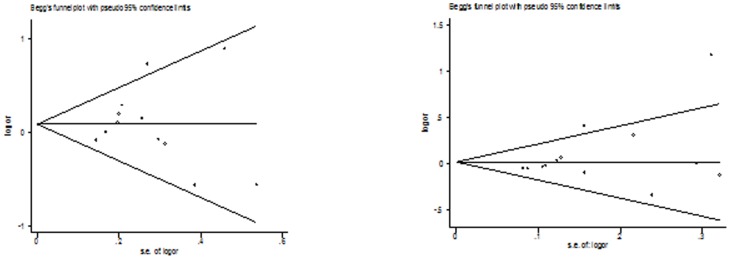
Begg's funnel plot of the meta-analysis of colorectal cancer risk and CYP1A2*F polymorphism (homozygote model and dominant model).